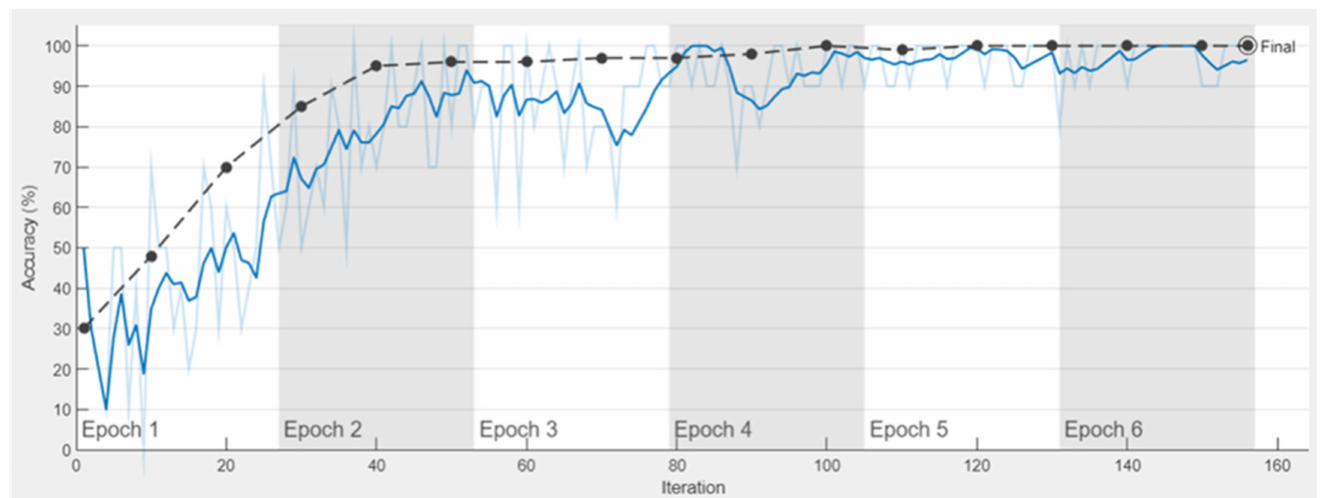
Figure 9. Training and validation accuracy progress for the seven classes of radial flux classification: training in light blue and in blue (smoothed), validation in black dashed.